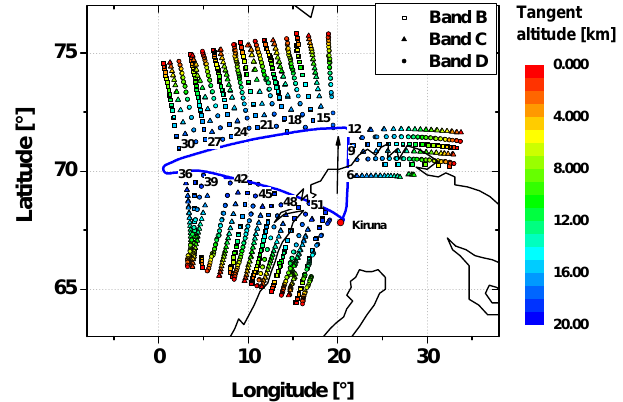
Figure 2. Geolocations of MARSCHALS limb sounding measure-